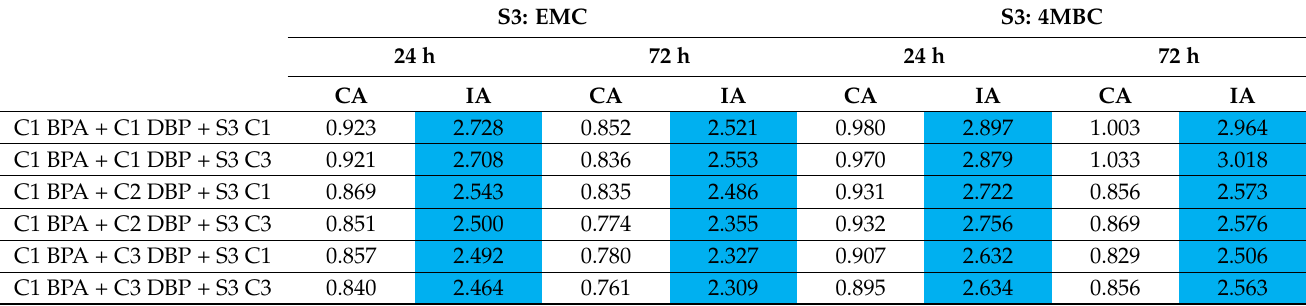
* red color indicates confirmed synergy, blue indicates antagonism, while yellow and green refer to under- and overestimation,